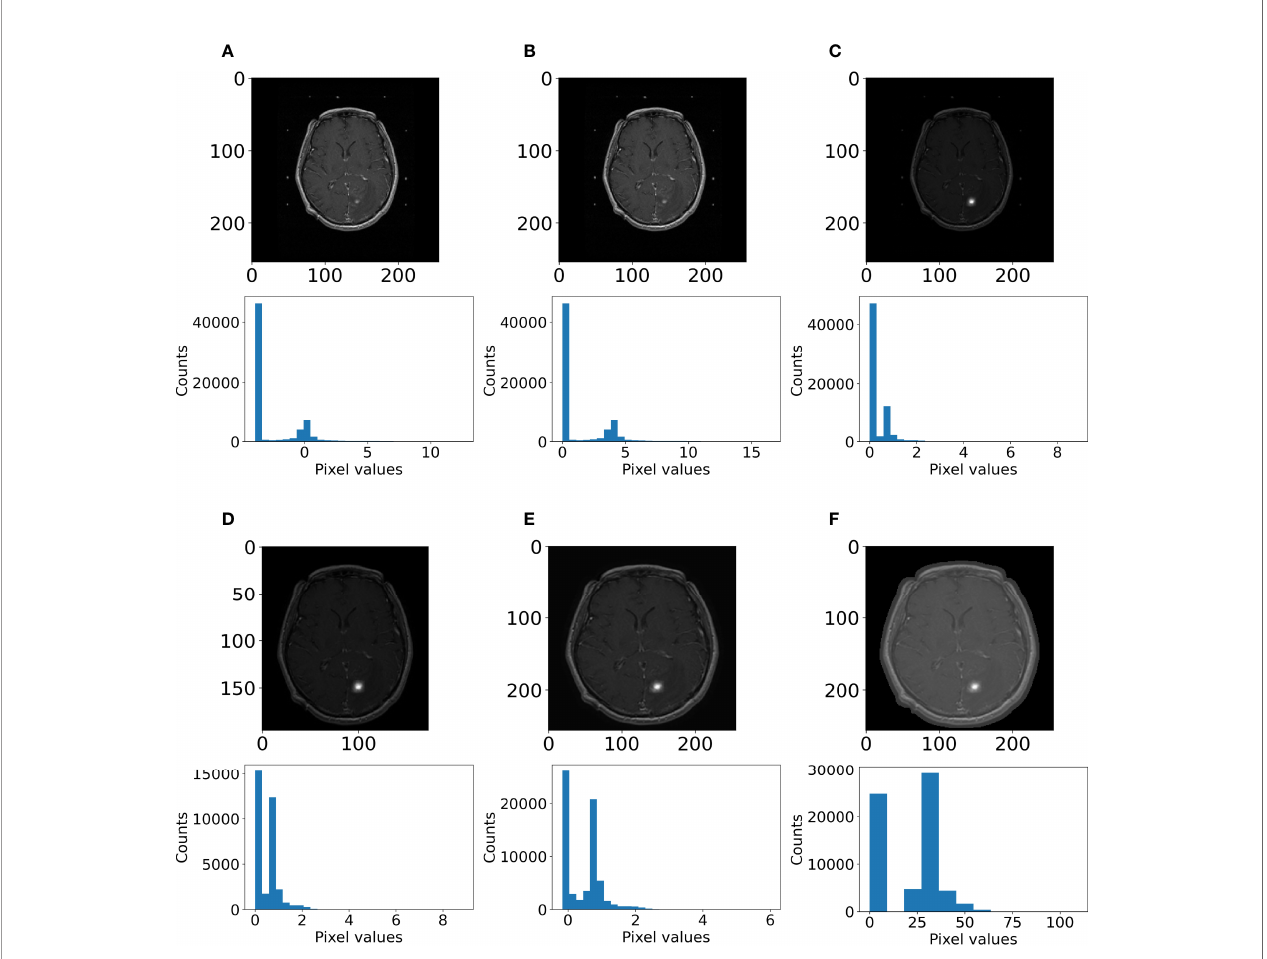
FIGURE 3 | Example of pre-processing strategy: deep learning on the “ minimalist ” approach. The different steps of preprocessing were (A) z-score normalization, (B) shift to positive values only, (C) pixel attenuations with Gaussian smoothing fi ltering, (D) cropping around the largest bounding box and background set to 0, (E) resizing at 256 × 256, and (F) rescaling the pixel value range to 0 –